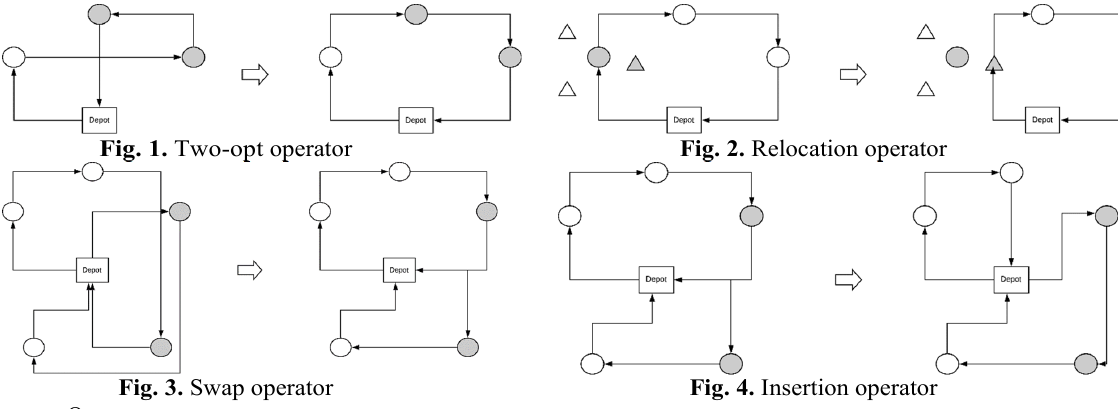
Fig. 3. Swap operator Fig. 4. Insertion operator